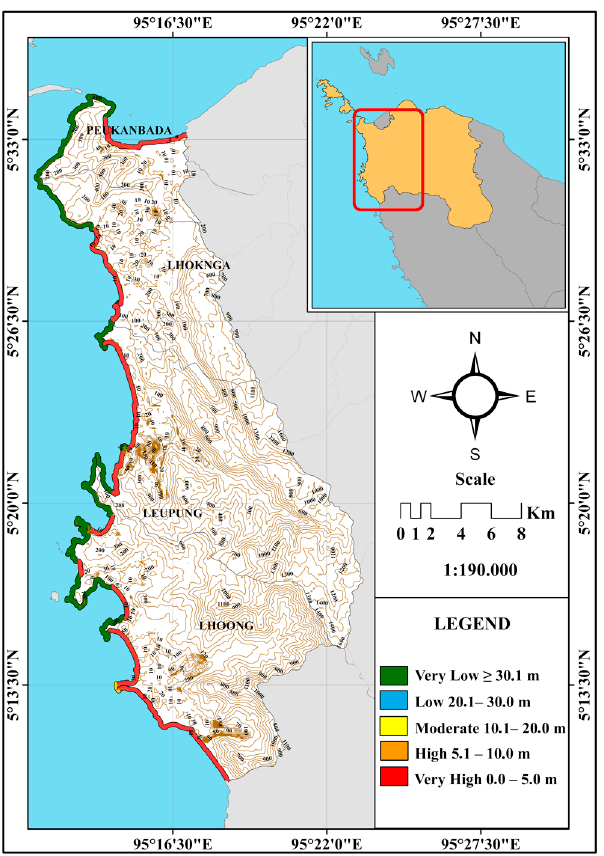
Figure 5. Level of vulnerability elevation resulting from the combination analysis between field data and DEMNAS data.